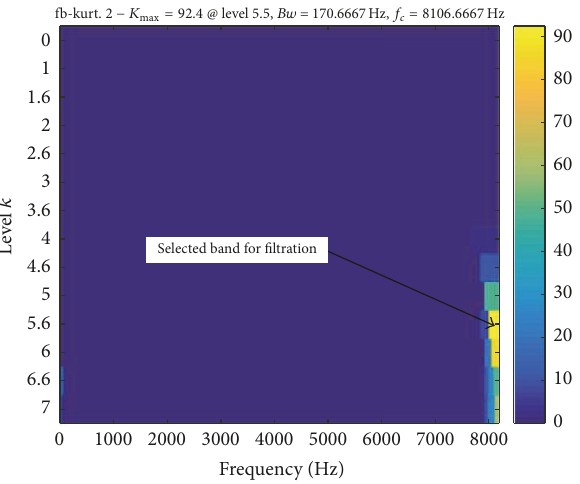
Figure 5: Kurtogram of the investigated